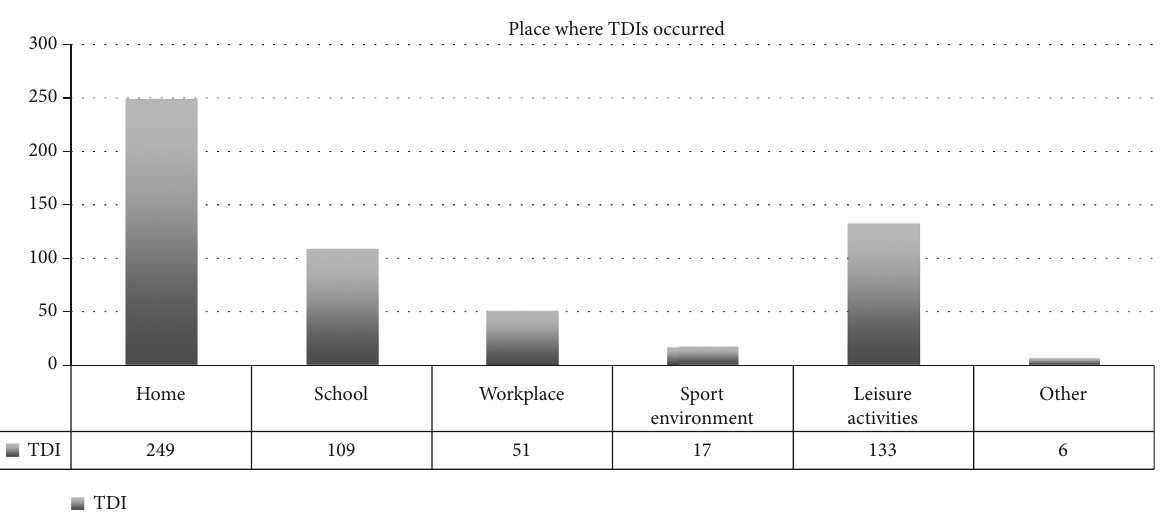
Figure 10: TDI frequency based on the place where injuries